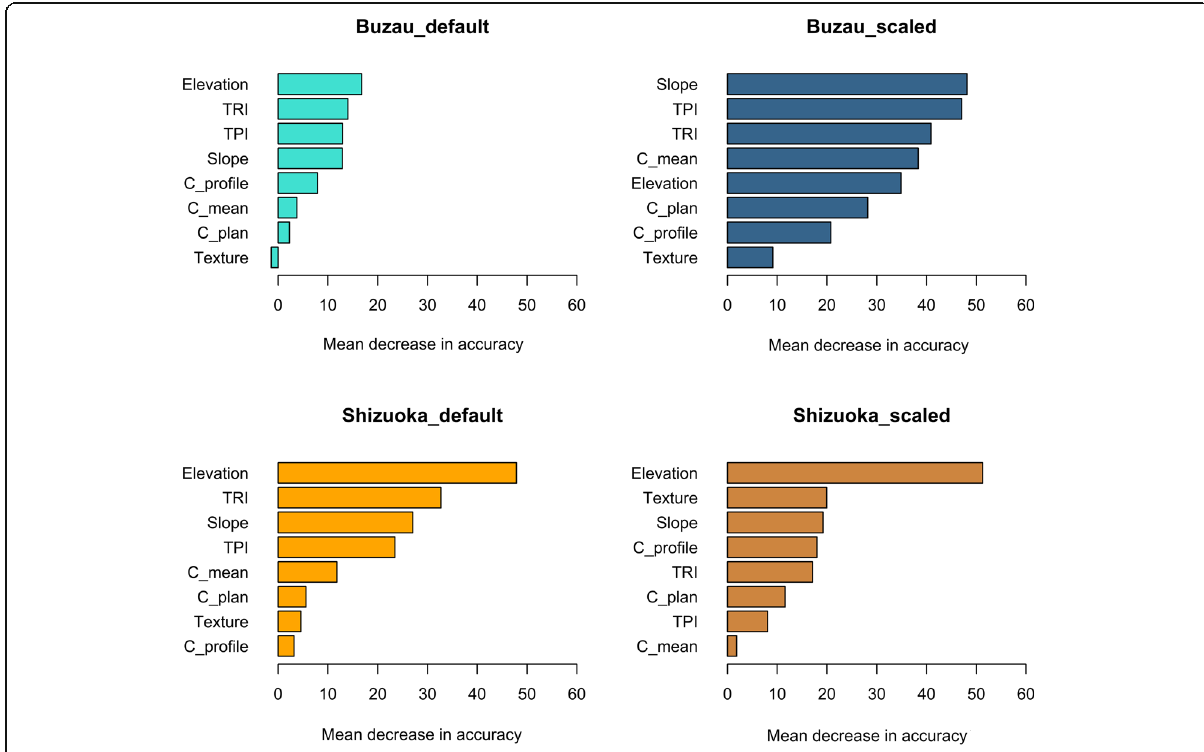
Fig. 8 Variable importance ranking, based on the random forest